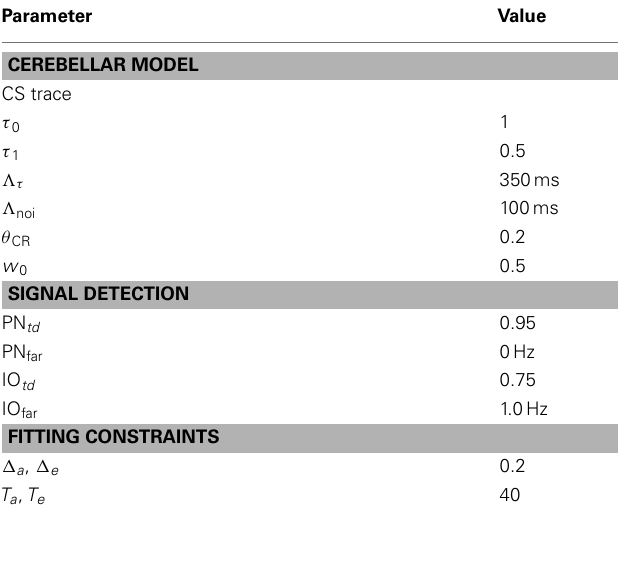
detections (green), IO detections (black), and CR triggers (blue, well-timed thick, and late thin). CS (yellow area) and US (pink area) periods.The horizontal dashed red line separates acquisition and extinction phases. Vertical blue line marks the limit for well-timed CRs. (B) Model without stability constraint. Data plotted as in (A) .